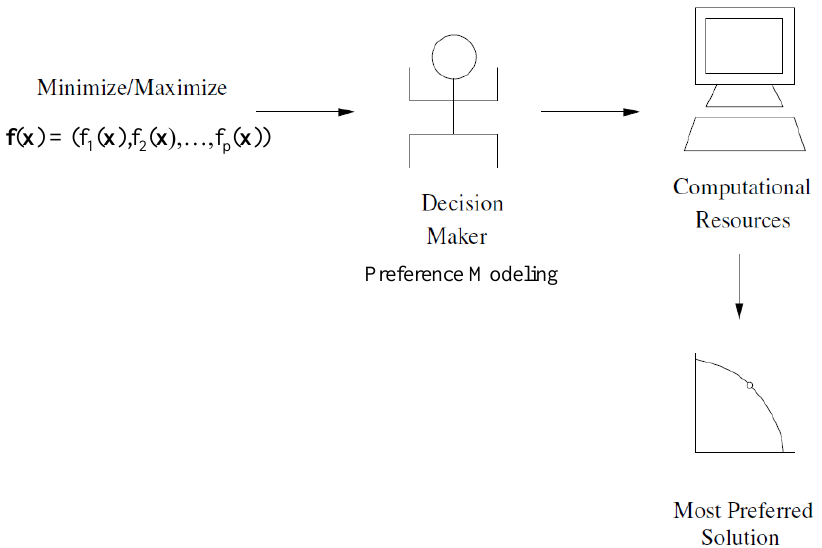
Figure 3. A priori